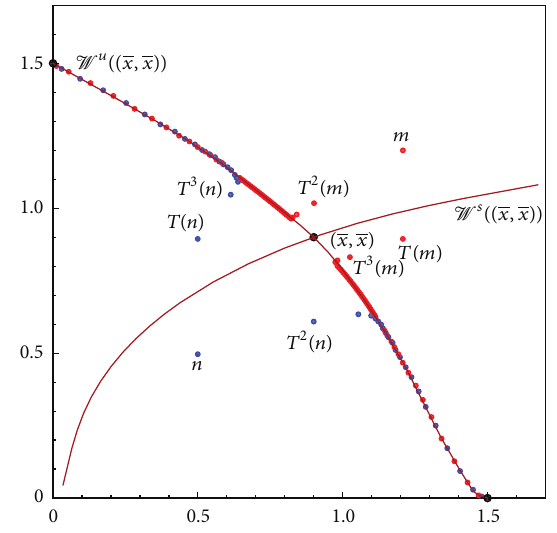
Figure 3: Global dynamics of (1) for 𝑎 = 1/9 , 𝑏 = 1/3 , and 𝑐 = 2/3 —an illustration of Theorem